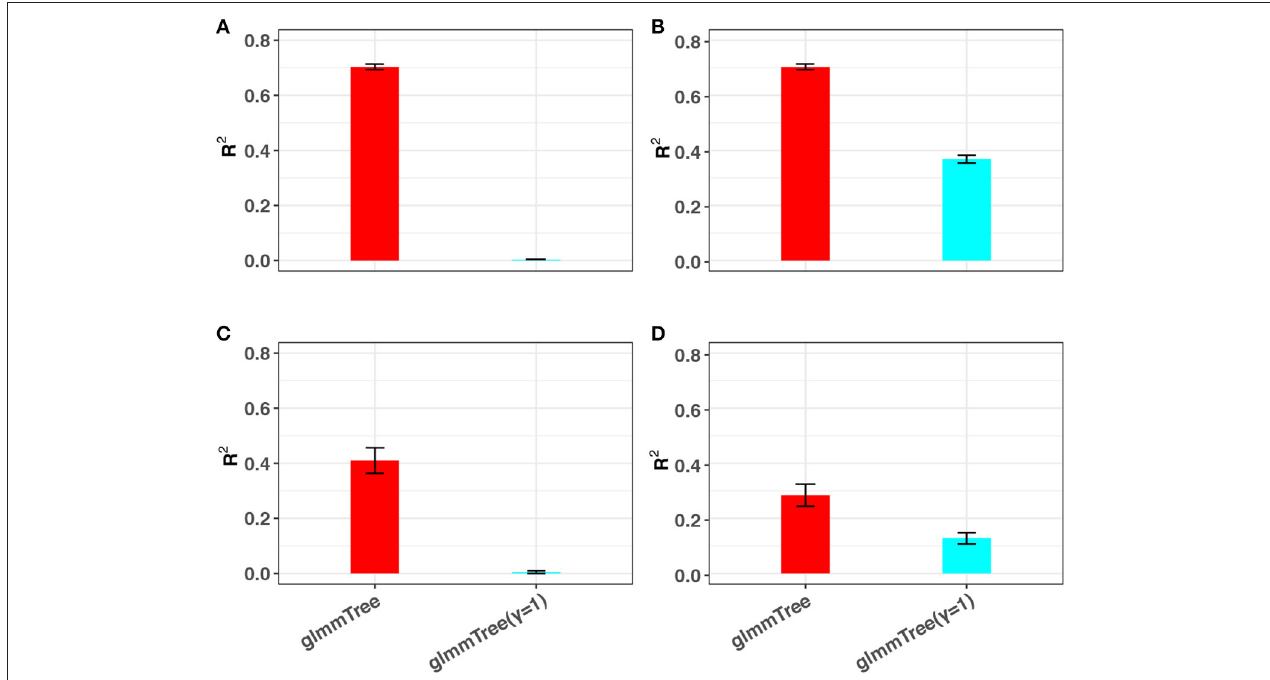
FIGURE 5 | The ability of glmmTree to capture non-linear effects through the tuning parameter γ . glmmTree with tunable γ (red) is compared to glmmTree with fixed γ = 1 (blue). R 2 is used to evaluate the performance for continuous (A,B) and binary (C,D) outcomes when the outcome is generated based on OTU presence/absence (A,C) and square-root transformed OTU abundances (B,D)